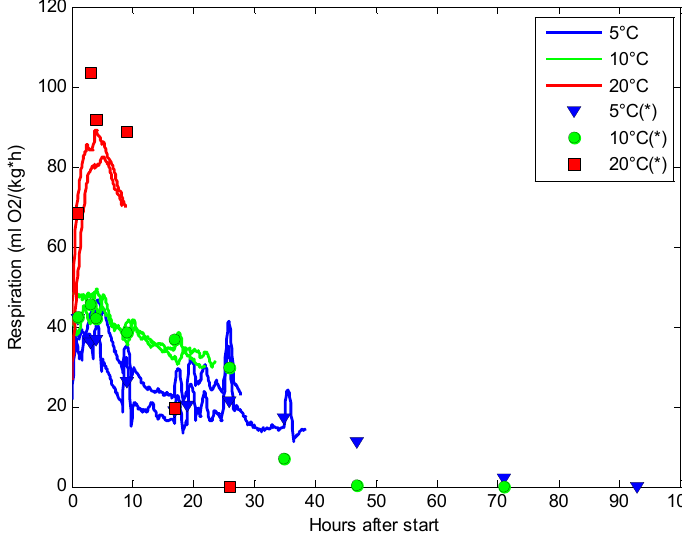
) for broccoli placed at 5 °C (blue lines), Figure 4. The estimated respiration rates (O 2 10 °C (green lines) and 20 °C (red lines) at hours after initiating the experiment, and the corresponding discrete reference measurements made by PBI Dansensor are shown as